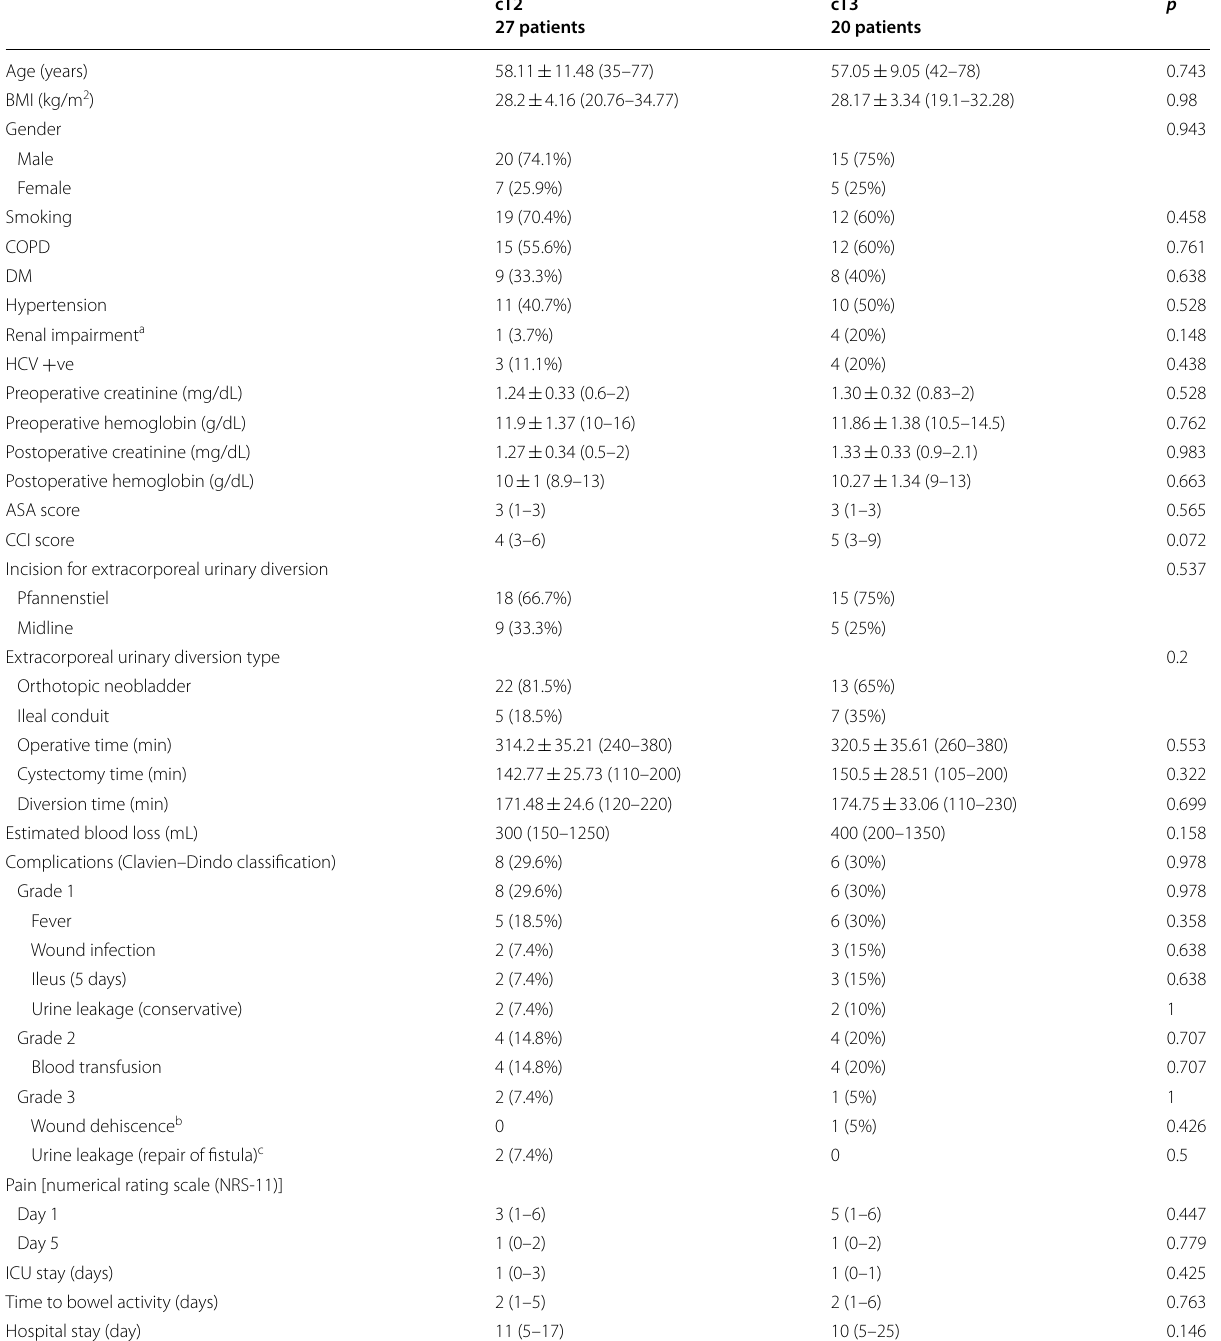
Table 2 Comparison of the two groups according to clinical